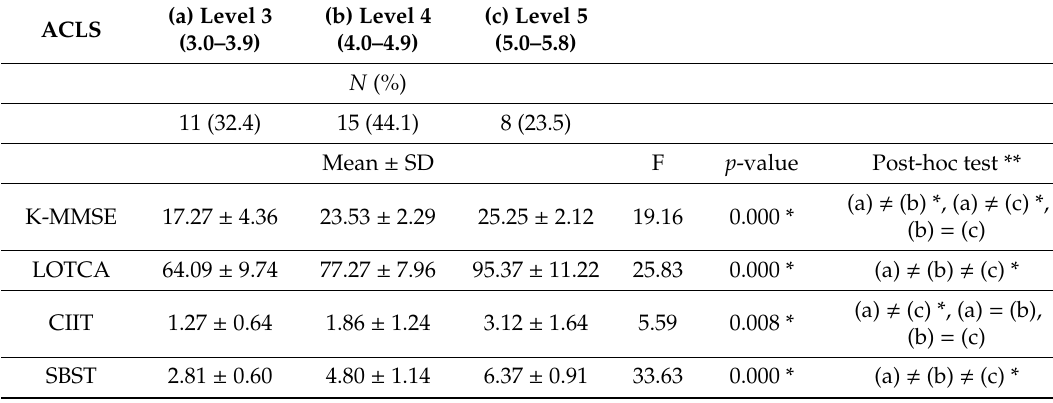
Table 2. Comparison of basic cognitive function and social cognition among ACLs of